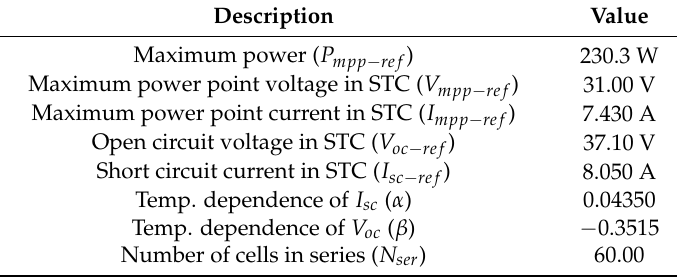
Table 1. Key parameters of JW-G2300-MD6660P-1 photovoltaic (PV) Module.